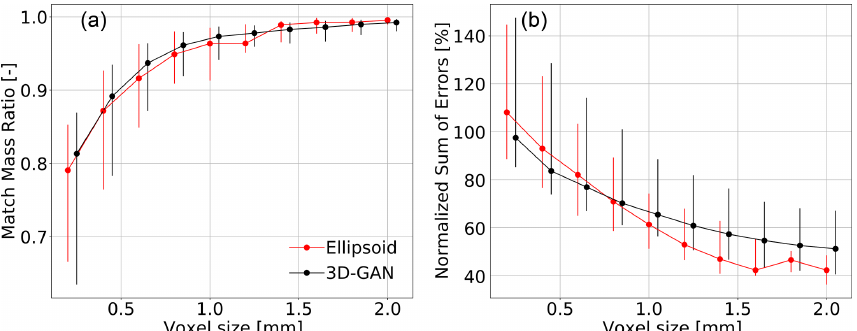
Figure 4. Distribution of matched mass ratio (MMR) (a) and normalized sum of errors (NSE) (b) values as a function of the grid volume size at which the evaluation is conducted. Median values over the evaluation sample are indicated by the markers, while the vertical lines overlap the 25th–75th percentile range. An artificial horizontal displacement is added to the data series to enhance readability. The reference method ( Ellipsoid ) corresponds to an optimal ellipsoidal fit of the reference snowflake with perfect mass match, as described in the